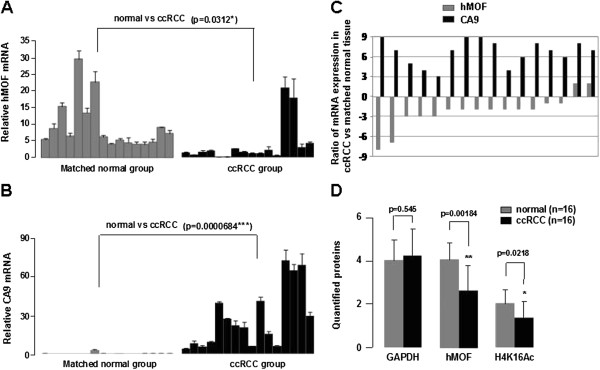
Downregulation of hMOF is accompanied by increased CA9 in ccRCC. A-B. Relative mRNA expression levels of hMOF and CA9 in ccRCC. Total RNA was isolated from sixteen paired clinical ccRCC and adjacent kidney tissues. Relative mRNA expression levels of hMOF and CA9 were analized by quantitative RT-PCR. Error bars represent the standard error of the mean of 3 independent experiments. Student’s t-test was performed to compare the difference between ccRCC and normal tissues. C. Expression patterns of hMOF and CA9 mRNAs in ccRCC and its corresponding adjacent kidney tissues. Expression is displayed as a ratio of expression of hMOF or CA9 gene in ccRCC versus matched normal tissues. Each bar is the log2 value of the ratio of hMOF or CA9 expression levels between ccRCC and matched normal tissues from the same patients. Bar value >1 represents >2-fold increased, whereas bar value <−1, represents >2-fold decreased. D. Protein expression levels of hMOF and its H4K16Ac status in ccRCC. Aliquots of whole cell extracts from sixteen selected ccRCC tumor samples and its corresponding adjacent tissues were analyzed by western blotting. The blots were then scanned and quantified with Quantity One software. The significant difference is expressed as *p<0.05, **p<0.01.